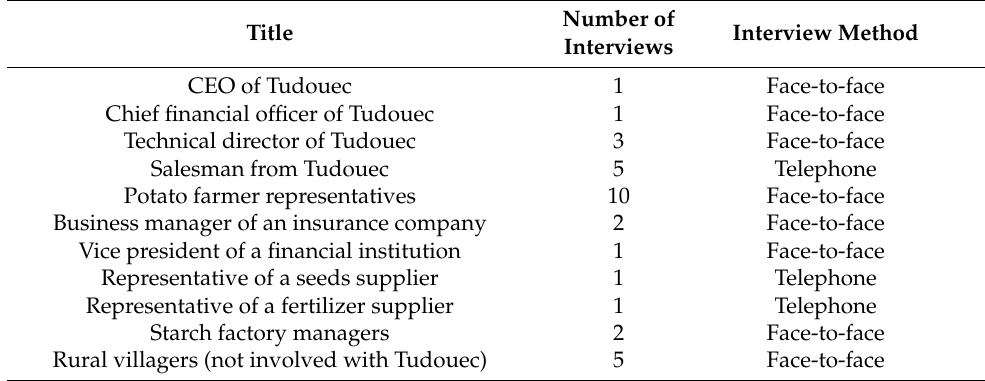
Table 2. List of